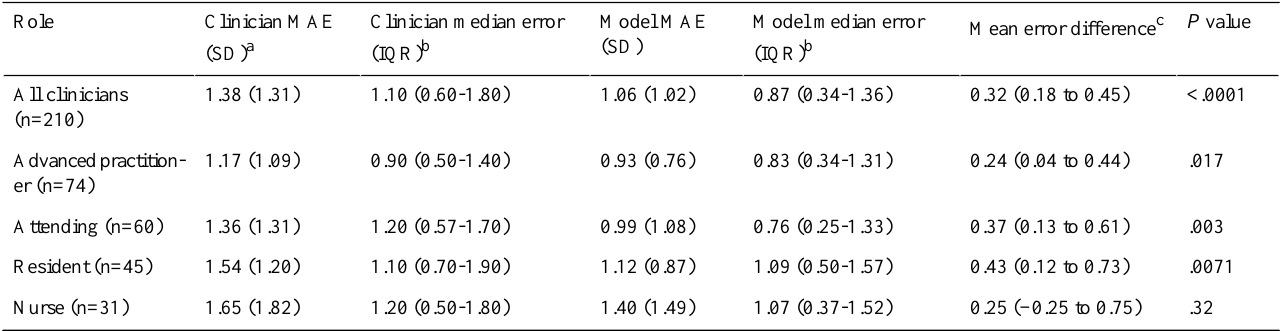
Table 3. Clinician prediction accuracy by role and comparison with the neural network predictive